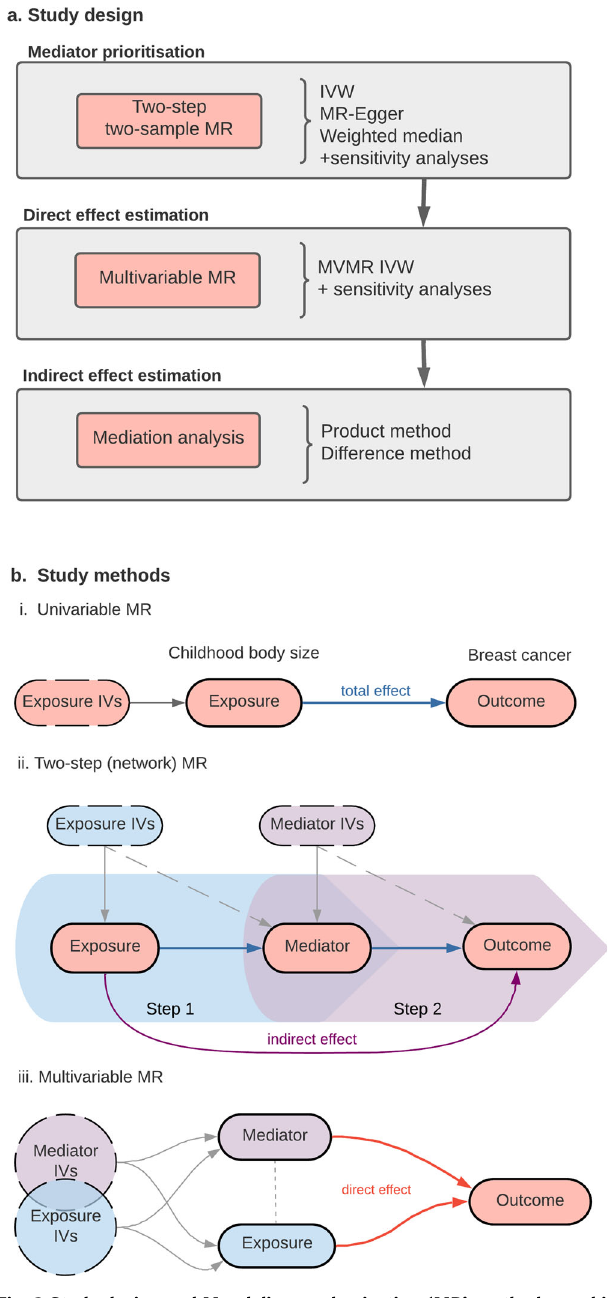
Fig. 2 Study design and Mendelian randomization (MR) methods used in the analysis. a Study design; b Study methods: (i) Univariable MR: simple two-sample setup, measuring the total effect of exposure (childhood body size) on the outcome (breast cancer); (ii) Two-step (network) MR: two sets of two-sample MR − step 1: the total effect of exposure on the mediator, step 2: the total effect of the mediator on the outcome, allowing the measurement of the indirect effect of exposure on outcome via mediator; (iii) Multivariable MR: both exposure and mediator are accounted for in a single model; the direct effect of both is estimated. Arrow colours represent effect: blue − total, red − direct, purple −